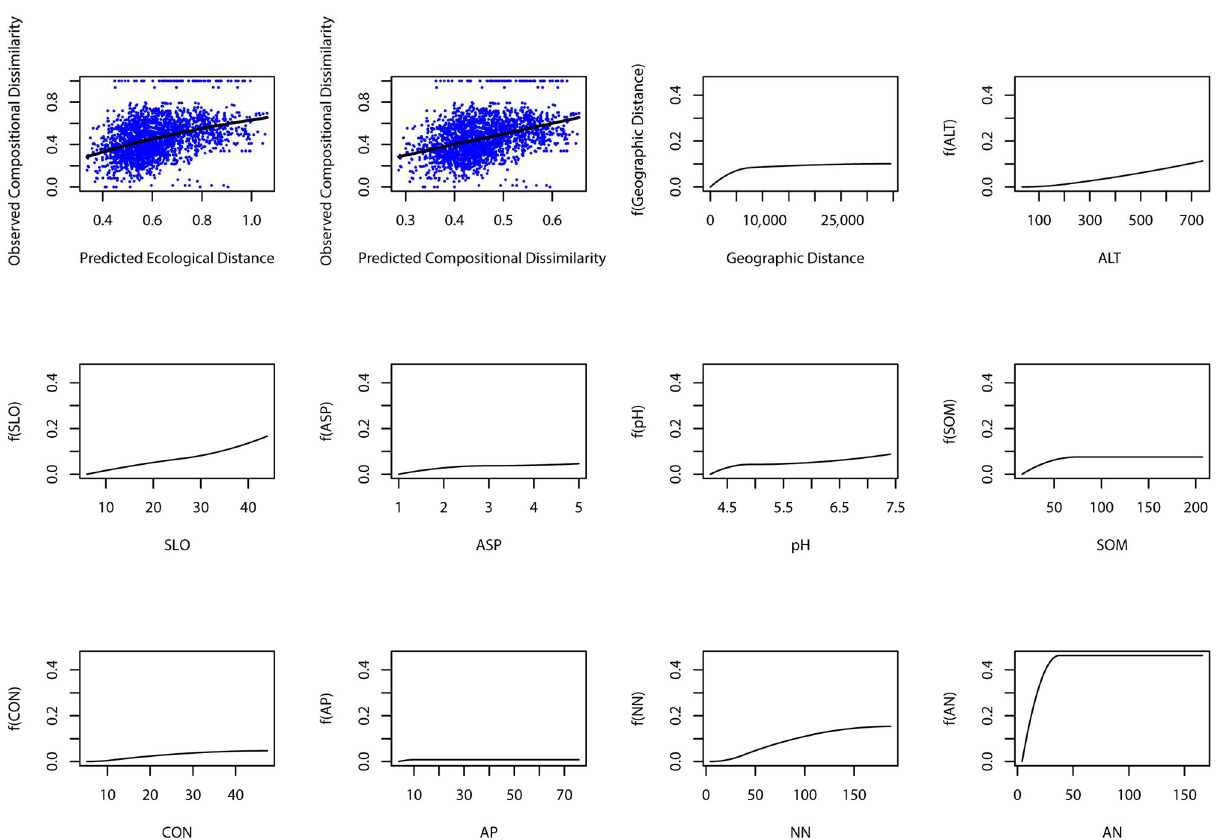
Figure 4. GDM for phylogenetic β sor of adults in secondary plant communities on Mount Lao. Each blue dot represents a site-pair. The units of the x-axis variables are original units. The y-axis indicates a transforming function “f” to each environmental variable, which is fitted by I-splines, and the unit is linked to community dissimilarity. The I-splines are partial regression fits and represents the importance of each predictor in determining patterns of β-diversity and total amount of compositional dissimilarity associated with each variable (the greater the ecological distance, the greater the explanatory power of the predictor). The shape of each function indicates how the rate of compositional dissimilarity varies along gradients, and the maximum height reached by each curve indicates the total amount of dissimilarity associated with each variable, maintaining all other variables as constant. If the curve reaches an asymptote, it indicates saturation of dissimilarity, and the variation of predicted ecological distance beyond it will not increase the dissimilarity. ELE: elevation; SLO: slope; POS: position; ASP: aspect; SOM: soil organic matter; CON: conductivity; AP: available phosphorus; NN: nitrate nitrogen; AN: ammonium nitrogen; AK: available potassium.